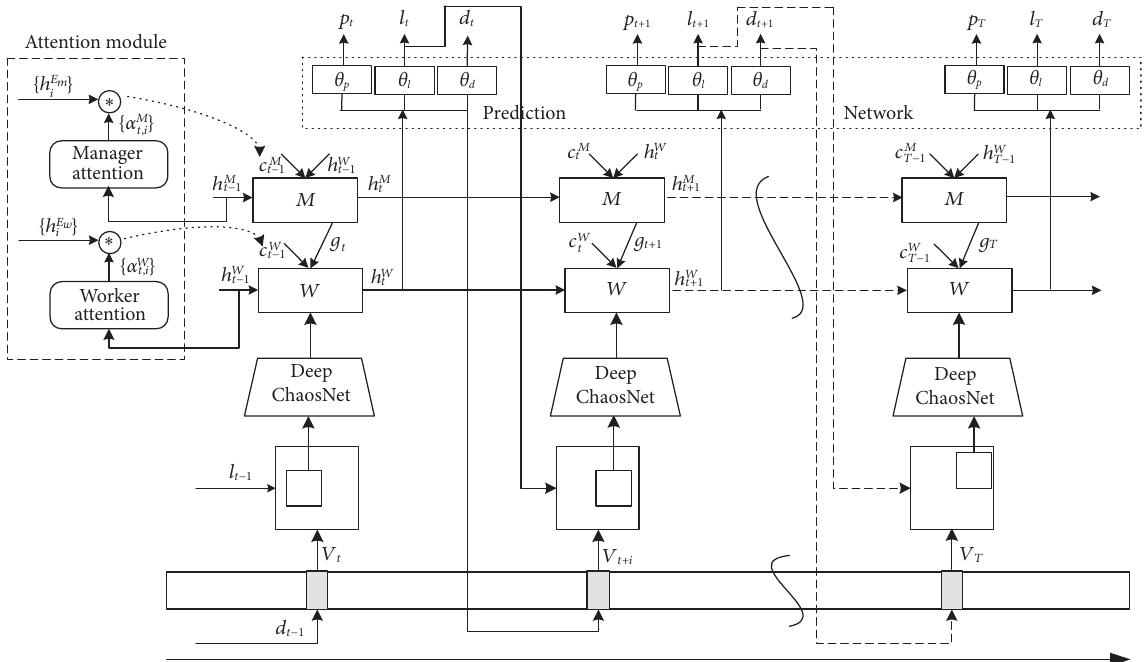
Figure 2: Illustration of the multilayer feature